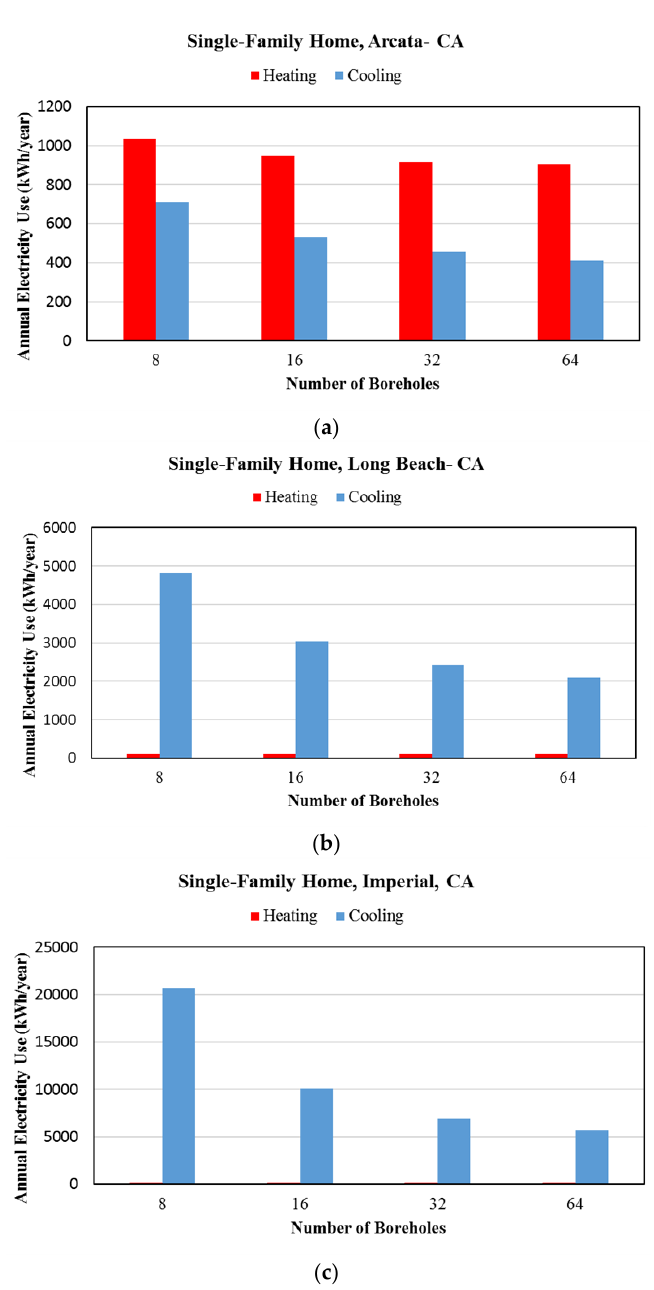
Figure 8. Annual heating and cooling electricity end-uses associated with various numbers of 22 ft (6.7 m) boreholes when the prototypical house is located in ( a ) Arcata, ( b ) Long Beach, and ( c ) Imperial.